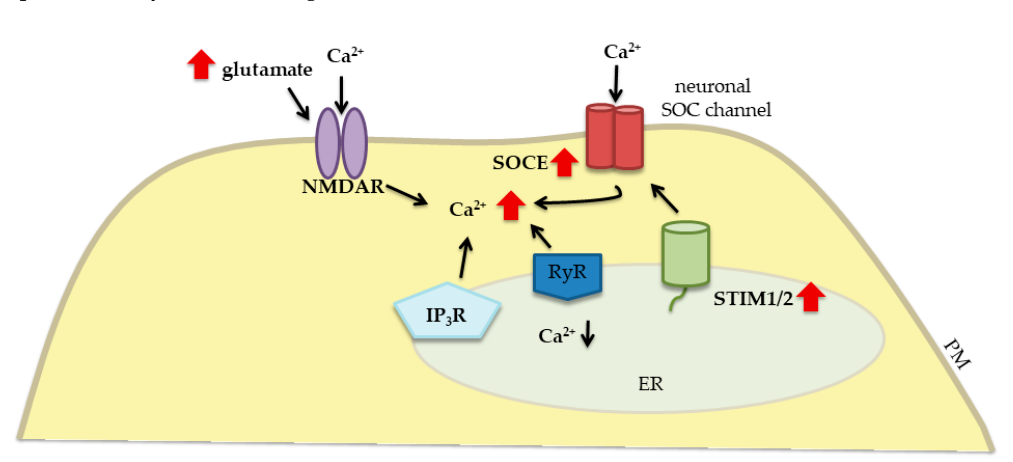
Figure 4. Contribution of neuronal STIM proteins and glutamate receptors to Ca 2 + signaling dysregulation in cerebral ischemia. The elevation of glutamate release leads to the excessive stimulation of glutamate receptors (e.g., NMDARs). The overactivation of NMDARs results in excessive Ca 2 + influx from both the extracellular space and ER stores, resulting in lower ER Ca 2 + levels, which in turn promote STIM-mediated SOCE and contribute to Ca 2 + overload. Solid black arrows represent the interaction mechanisms; red solid arrows symbolize increased expression/concentration.